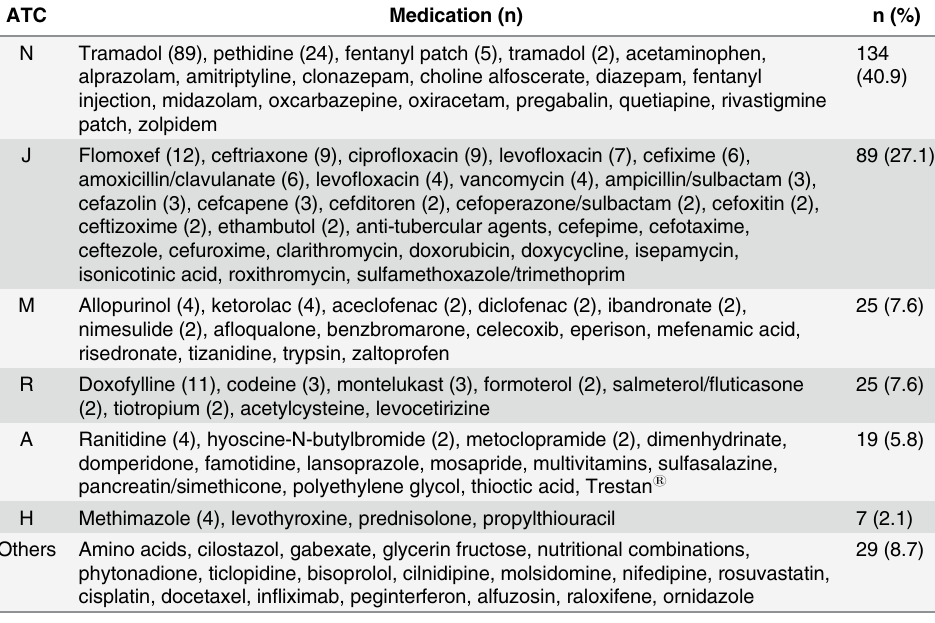
Table 3. The anatomical therapeutic chemical (ATC) classification of drugs involved in drug-induced adverse reactions (D-ADRs). ATC Medication (n) n (%) Tramadol (89), pethidine (24), fentanyl patch (5), tramadol (2), acetaminophen, alprazolam, amitriptyline, clonazepam, choline alfoscerate, diazepam, fentanyl